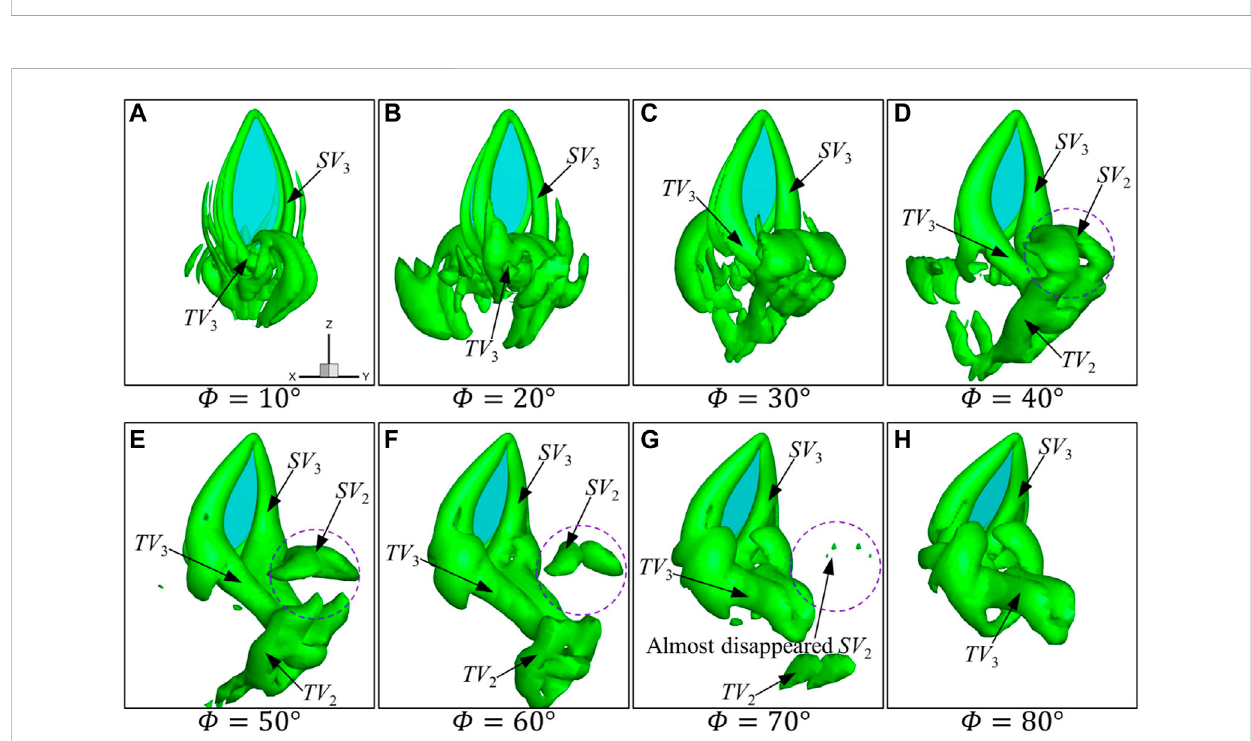
FIGURE 6 Instantaneousvortexstructureofthewingfordifferentamplitudesat Φ (A – H) τ (cid:1) 0 . 5.Inallsnapshots,theiso-surfaceoftheQcriterionwithQ (cid:1) 2is